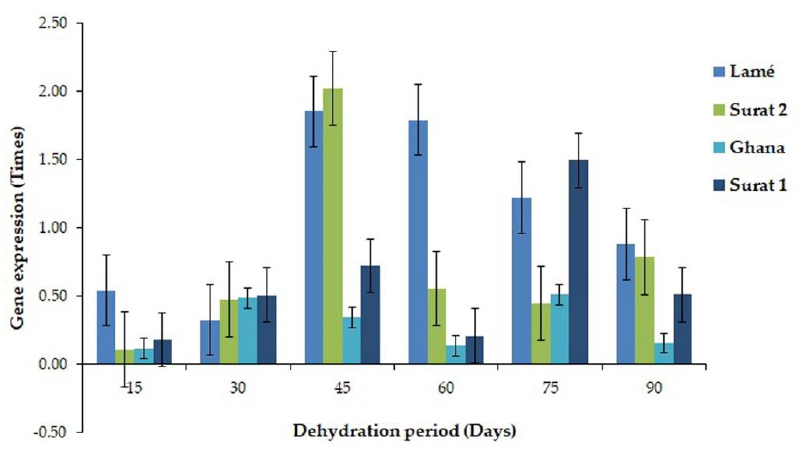
Figure 6. Gene expression value of H2A in a leaf of different oil palm varieties at different periods of water deficit .